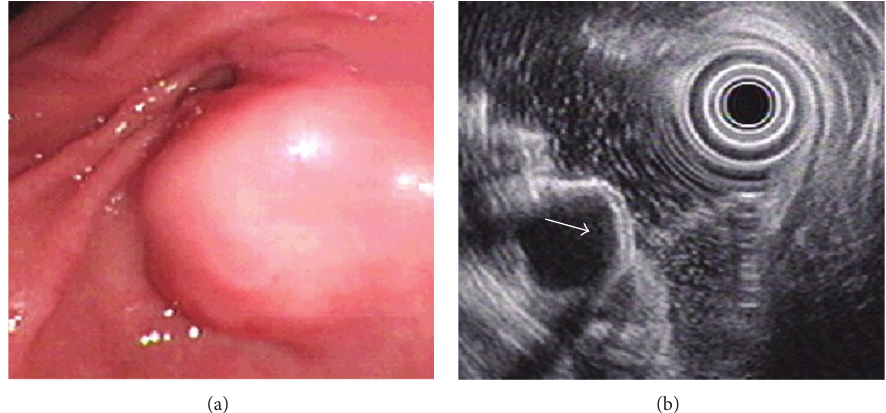
Figure 3: Ectopic pancreas originates from the fourth sonographic layers of the gastric wall. (a) A subepithelial tumor with intact mucosa was identified at antrum. (b) Endoscopic ultrasonographic image obtained with a 12 MHz catheter probe. The tumor exhibits homogenous, hypoechoic echogenicity and distinct margin originating from the fourth sonographic layer of gastric wall (arrow).